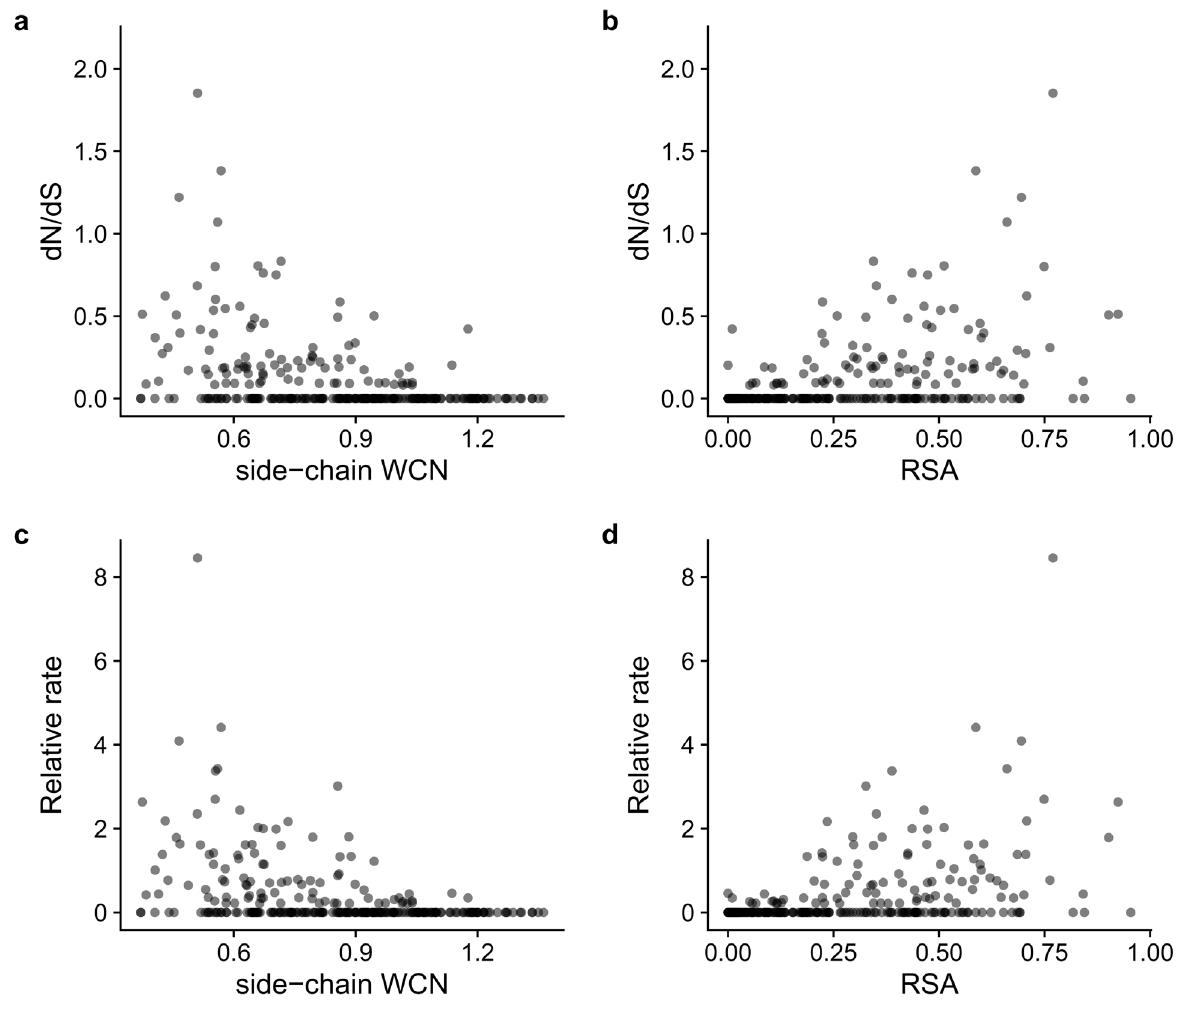
Figure 1. Amino-acid packing density and solvent accessibility correlate with site specific evolutionary rates. ( a – d ) Each point represents a residue in the structure of the HRH1 protein (PDB: 3rze). The Pearson correlation coefficients r between structural features (RSA or WCN) and rates ( dN / dS or amino acid) are as follows for each panel: ( a ) –0.39, (b) 0.43, ( c ) –0.39, ( d )